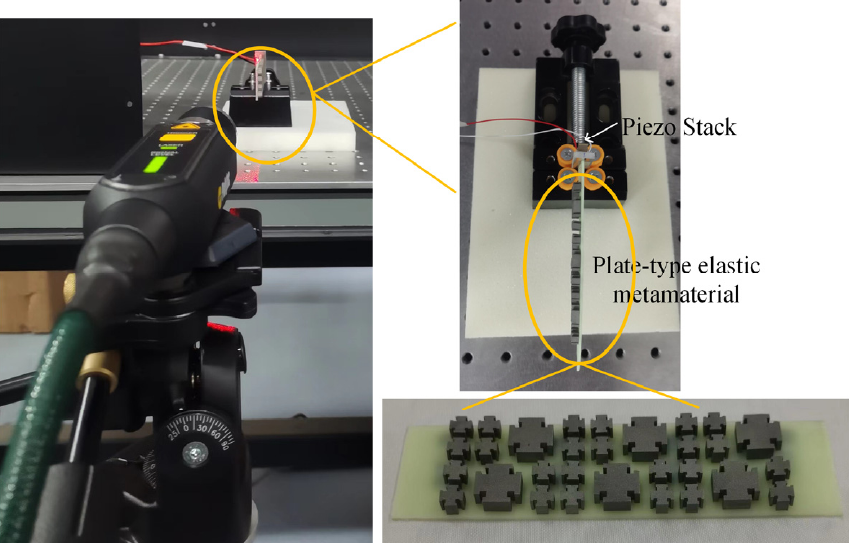
Figure 10. The setup of experimental measurement and the plate-type elastic metamaterial sample diagram.